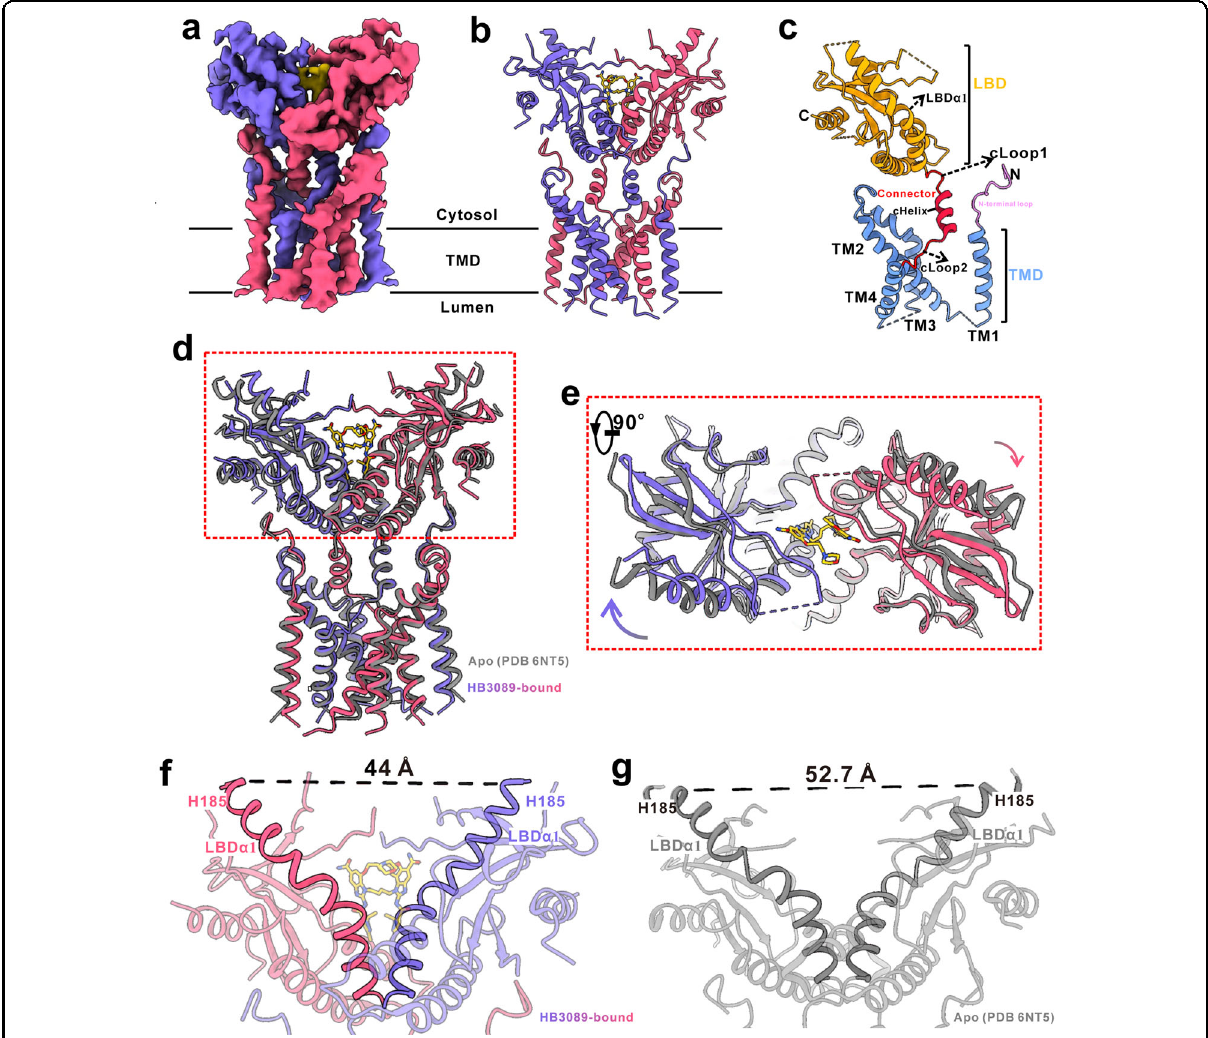
Fig. 2 The HB3089-induced conformational changes of ligand-binding domain of STING. a A side view showing the density map of the HB3089-bound STING. The two monomers and the HB3089 are colored in purple, red and yellow, respectively. b A ribbon representation of the HB3089-bound STING. The two monomers and HB3089 are colored as in a . c The atomic model of a STING monomer. The LBD, the connector, the TMD and the N-terminal loop are colored in orange, red, blue and pink, respectively. The connector links LBD α 1 of the LBD to the fi rst transmembrane helix (TM1) of the TMD through the C- and N- terminal loop of the connector (cLoop1 and cLoop2, respectively). d Structural comparison between the apo full-length STING (PDB 6NT5) and the HB3089-bound full-length STING (this study). The HB3089-bound STING is colored as that in b . The apo STING is colored in grey. e A top view of the boxed region in d , showing the conformational change of the LBD. f , g The inter-C α distance between residues His185 at LBD α 1 of the two STING forms in d